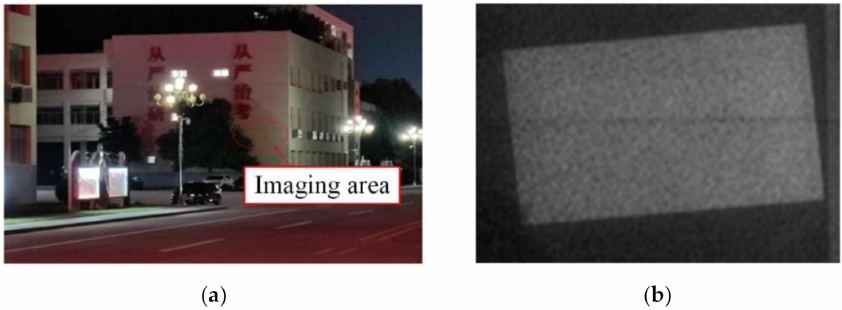
Figure 24. Wall and light spot at a distance of 120 m: ( a ) The Flat large wall; ( b ) Light